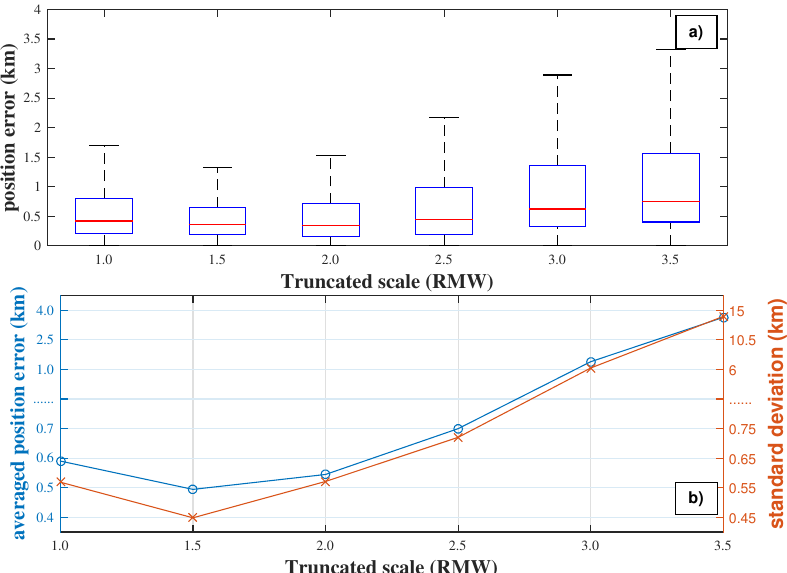
Figure 3. The statistics of position error according to normalized truncated scale. ( a ) the boxplot of position error. ( b ) the group averaged position error (blue line and circles) and standard deviation (red line and crosses) in each